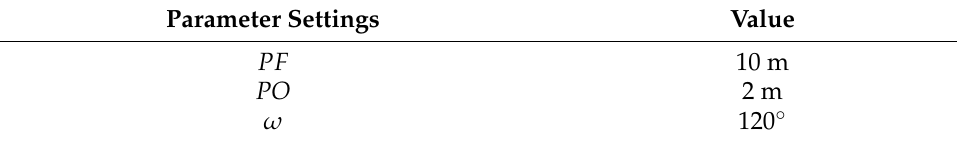
Table 1. Parameter settings of O-AUV.